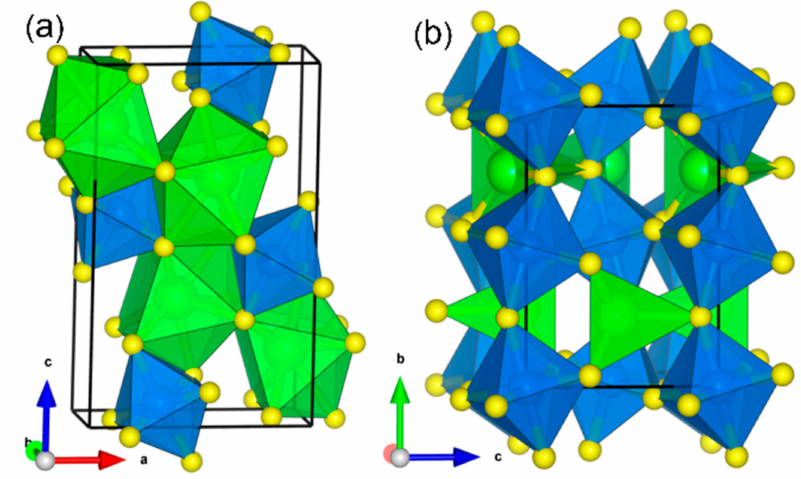
Figure 1. Crystal structure of ( a ) α –SrZrS 3 and ( b ) β –SrZrS 3. Color code: Sr = Green, Zr = Blue, and S =